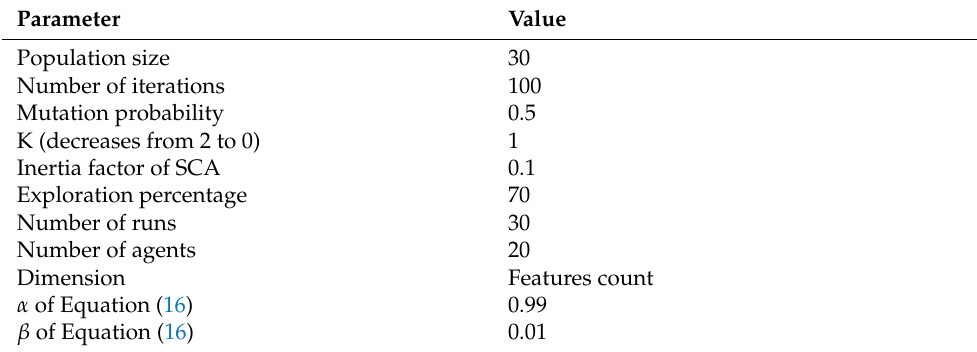
Table 3. Configuration parameters of the proposed